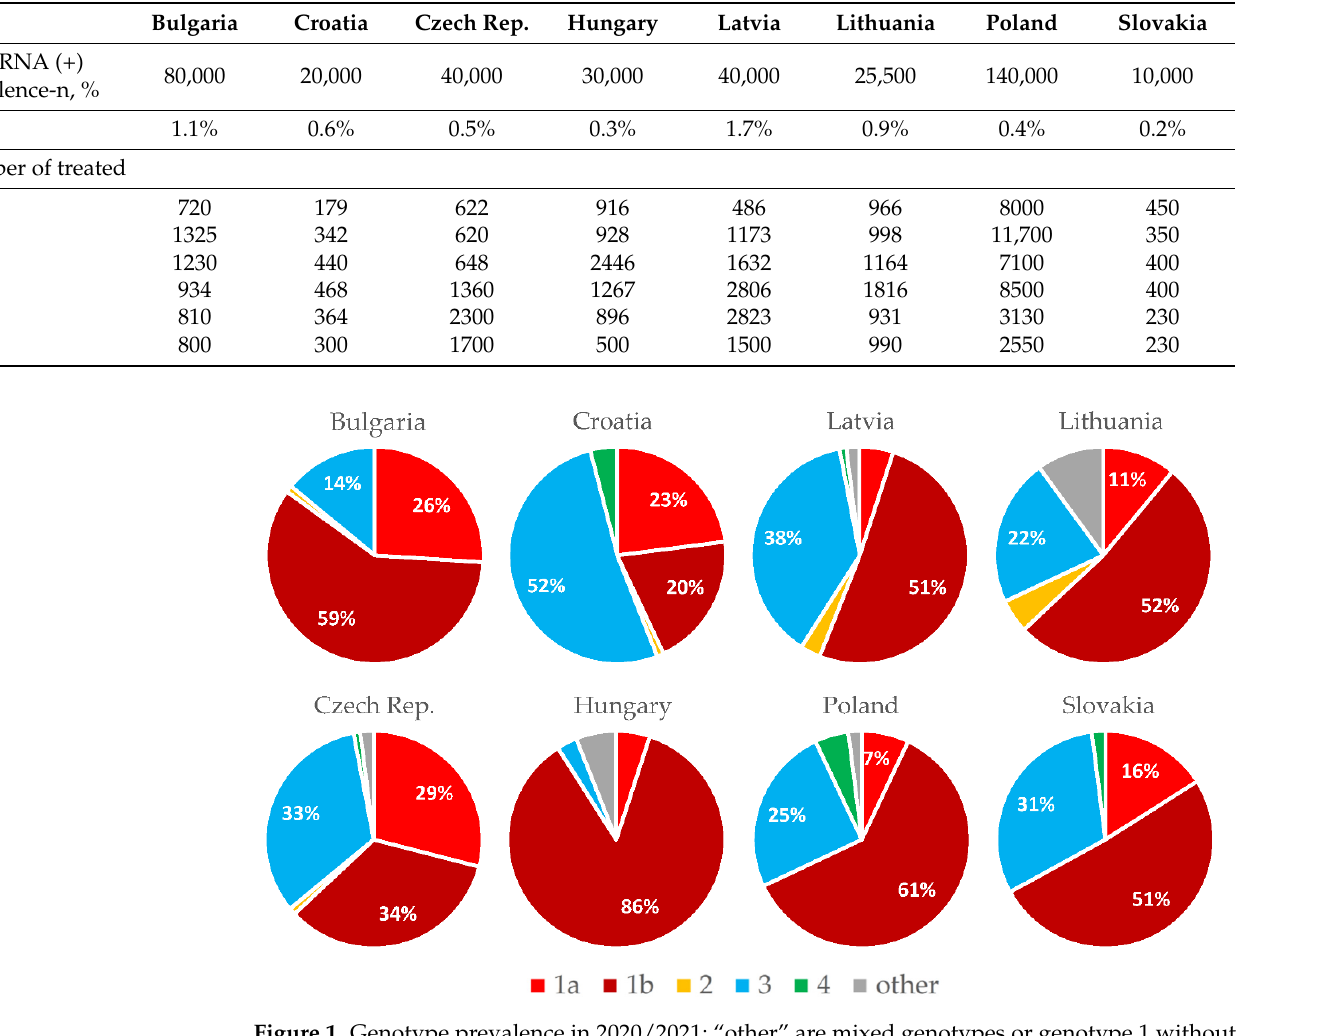
Figure 1. Genotype prevalence in 2020/2021; “other” are mixed genotypes or genotype 1 without specifying a subtype.